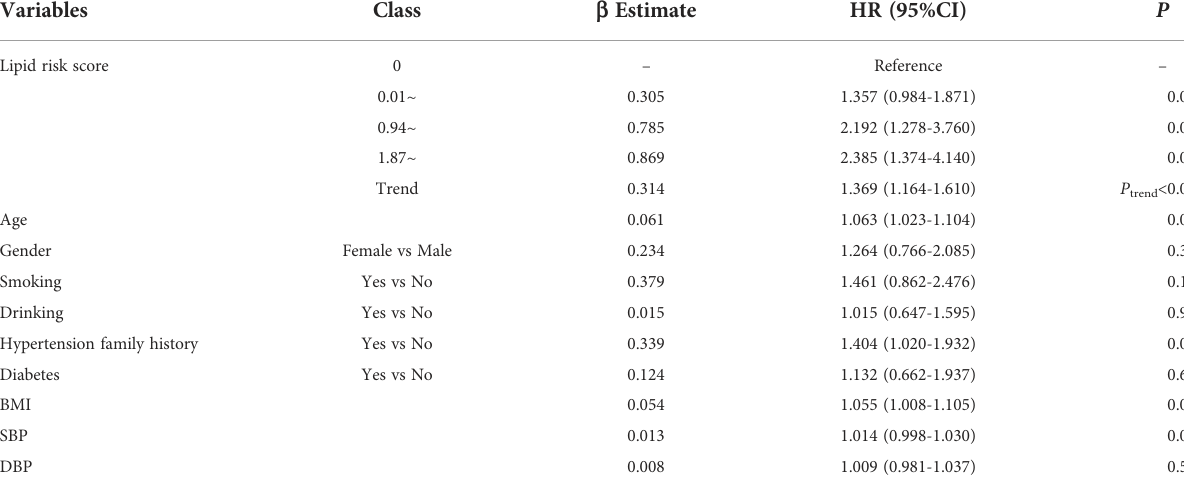
TABLE 4 Multivariable analyses of lipid risk score and incident hypertension in population< 55 years. Variables Class b Estimate HR (95%CI) P